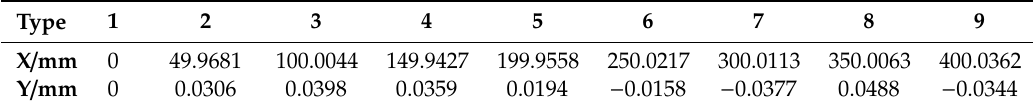
Table 2. Calibration results of the elliptical paraboloid